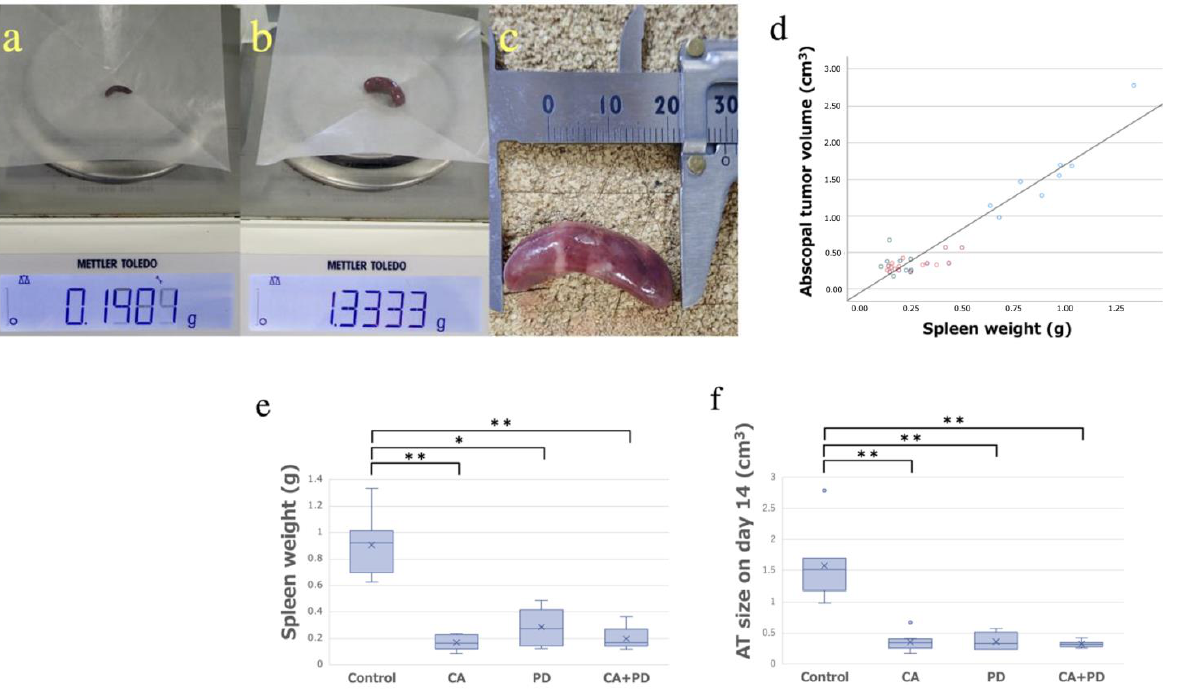
Figure 2. ( a ) Spleen weight of the No. 1 sample in the CA + PD group. ( b , c ) Spleen weight and size of the No. 4 sample of the Control group in splenomegaly condition. ( d ) Correlation between the spleen weight and AT size. A significant correlation was observed, with a Spearman correlation coefficient of 0.70. ( e , f ) There was a similar trend between the spleen weight and the AT size as there was a significant difference between the Control and other groups (* p < 0.05, ** p <